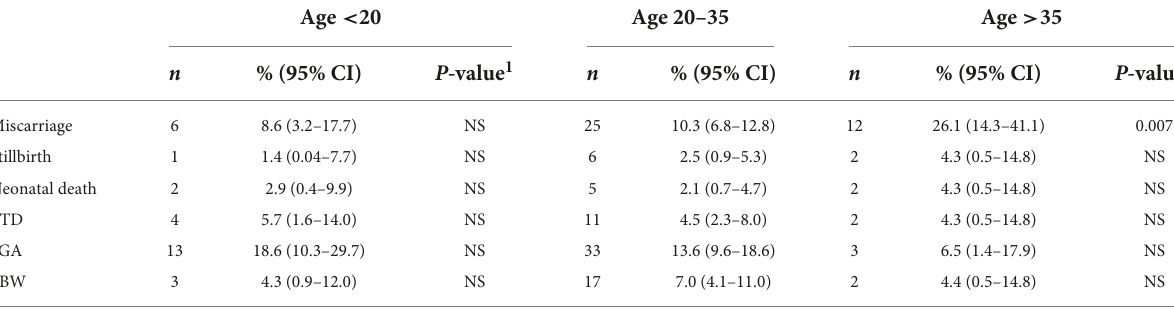
TABLE 3C Adverse outcomes in the study population by